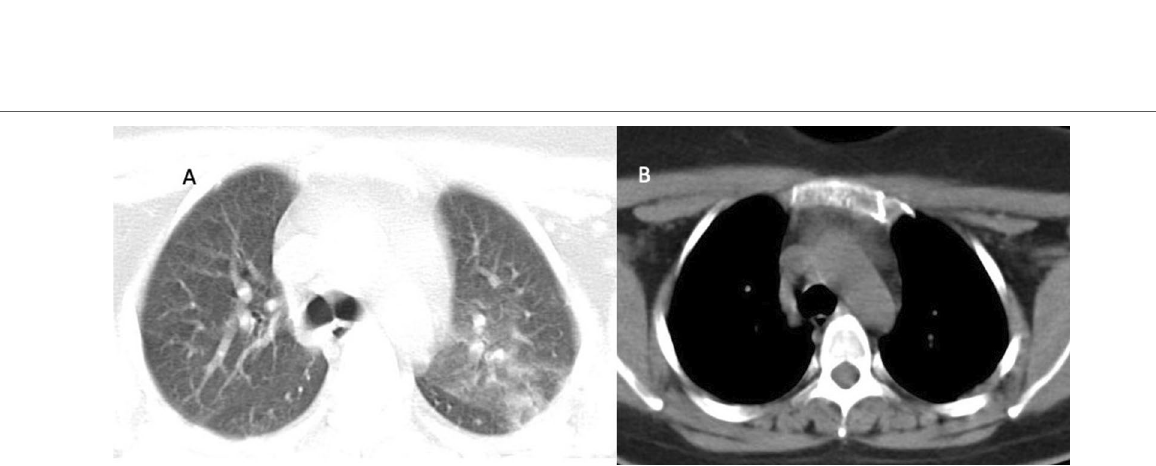
) patient with CT-SS 1 ( A ) and nodular-type thymus ( B ) +